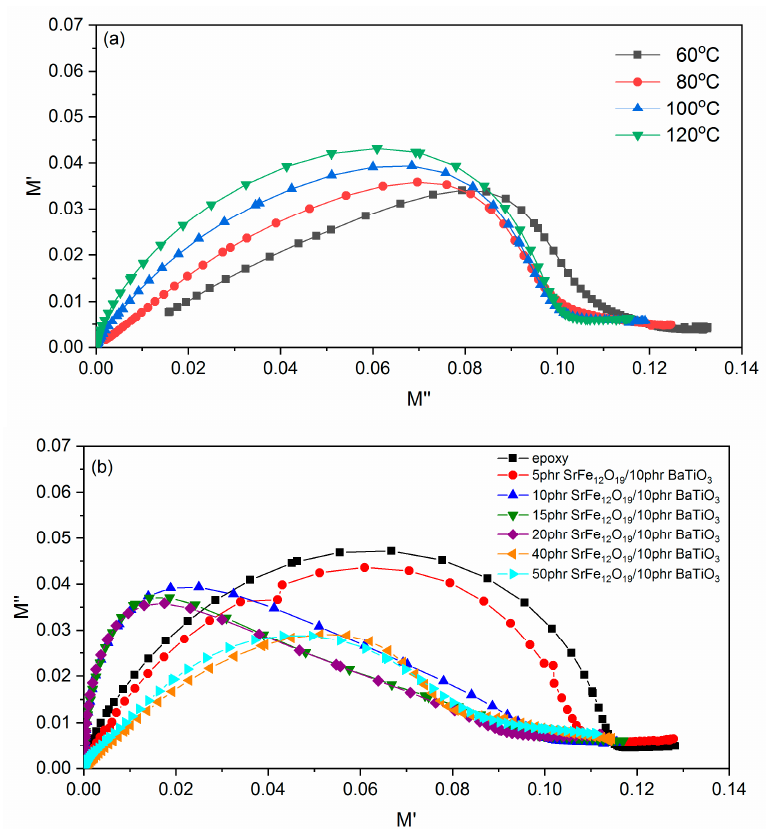
Figure 8. Cole–Cole plots for the: ( a ) 10 phr SrFe 12 O 19 /10 phr BaTiO 3 /epoxy nanocomposite at several temperatures and ( b ) for all examined systems at 100 °C.